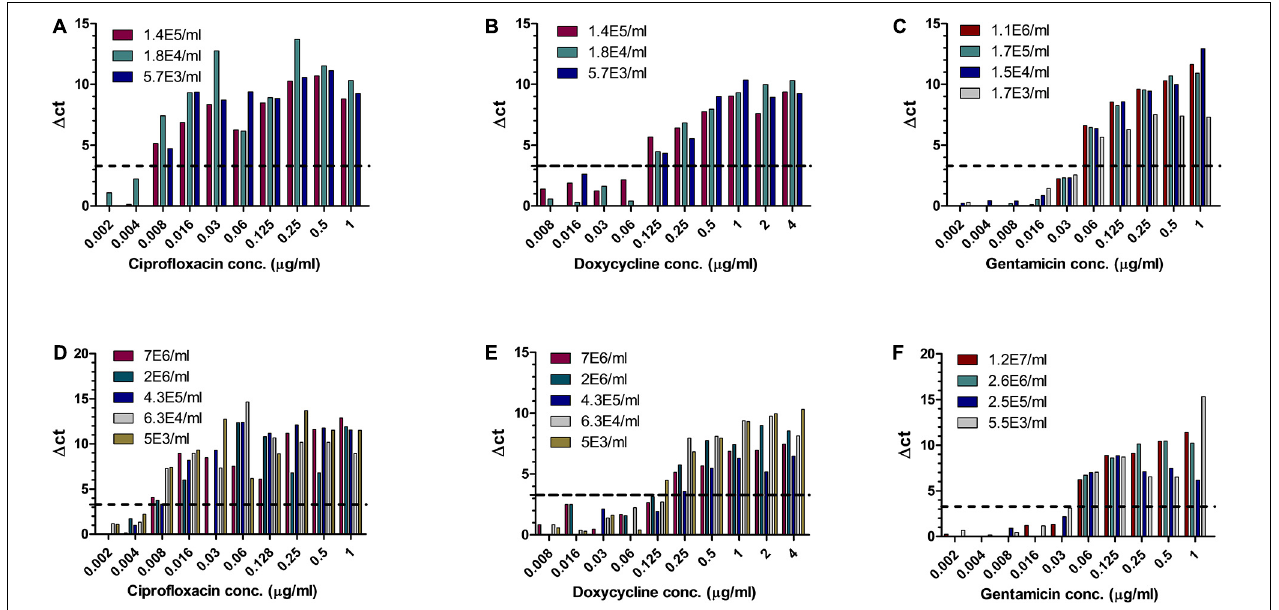
FIGURE 1 | MIC determination of blood cultures and whole blood samples spiked with F. tularensis . Human blood cultures (A–C) and human whole blood samples (D–F) inoculated with different concentrations of F. tularensis (cfu/ml) were subjected to AST for ciprofloxacin, doxycycline, and gentamicin by the MAPt analysis. MICs were determined, as described in the Materials and Methods section, by the threshold (cid:49) CT = 3.3.